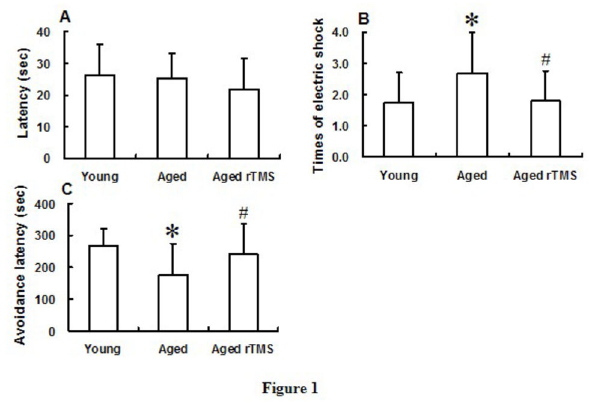
Figure 1. The performance of passive avoidance test altered in mice exposed to aging and rTMS. (A) There were no significant changes in the latency of the first day (shown is latency to enter into the dark box on adaptation trial). (B) The times of electric shock in the second day were significantly increased during aging and reduced significantly by rTMS (shown is the times of electric shock to enter into the dark box on acquisition trial; * P <0.05 vs young group; # P <0.05 vs aged group). (C) Reduced passive avoidance latency of aged mice in the third day was enhanced significantly by the application of rTMS (shown is latency to enter into the dark box on retention trial; * P <0.05 vs young group; # P <0.05 vs aged group). Data were presented in mean ± SD (n=15 in each group).